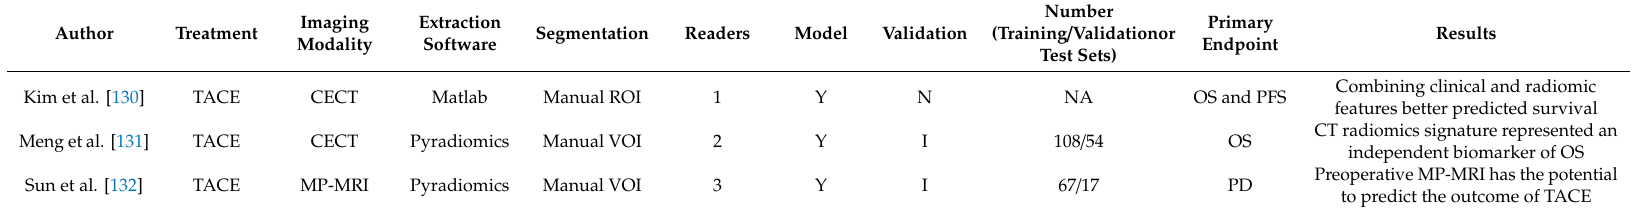
Table 4. Summary of studies that applied radiomics in predicting progression and survival after transarterial